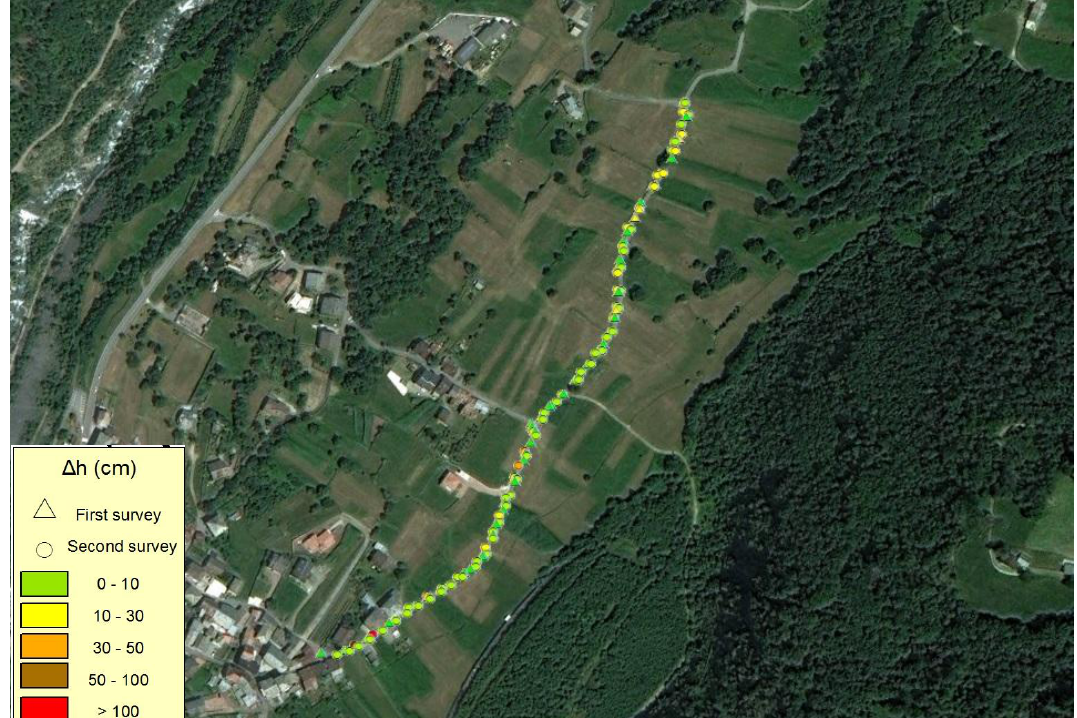
Figure 6. VT09 area: GNSS RTK results and differences with respect to HR DTM